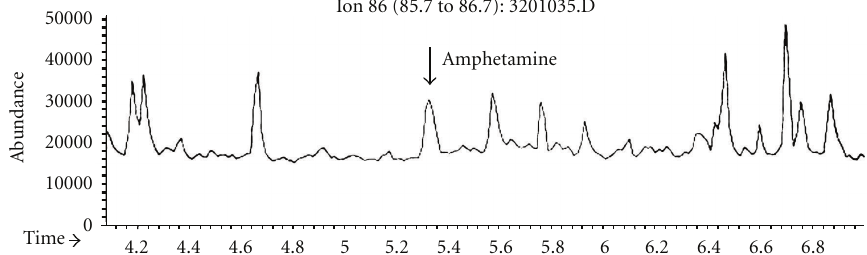
Figure 2: Gas chromatography-mass spectrometry (GCMS) of the brain tissue: single-ion monitoring for amphetamine (target ion 86 dalton, retention time 5.33 mins). Calibration was performed with spiked serum samples up to 0.1mg/L and led to a concentration of 0.017 µ g/g brain